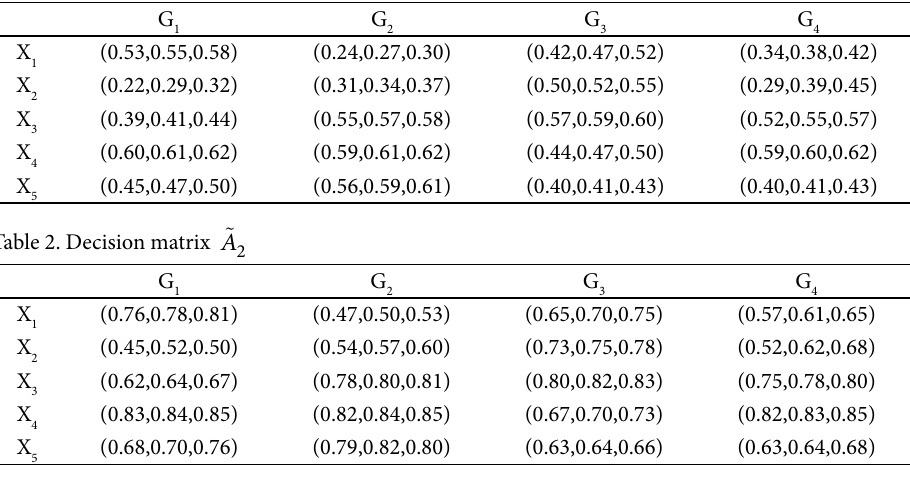
Table 1. Decision matrix 1 A 